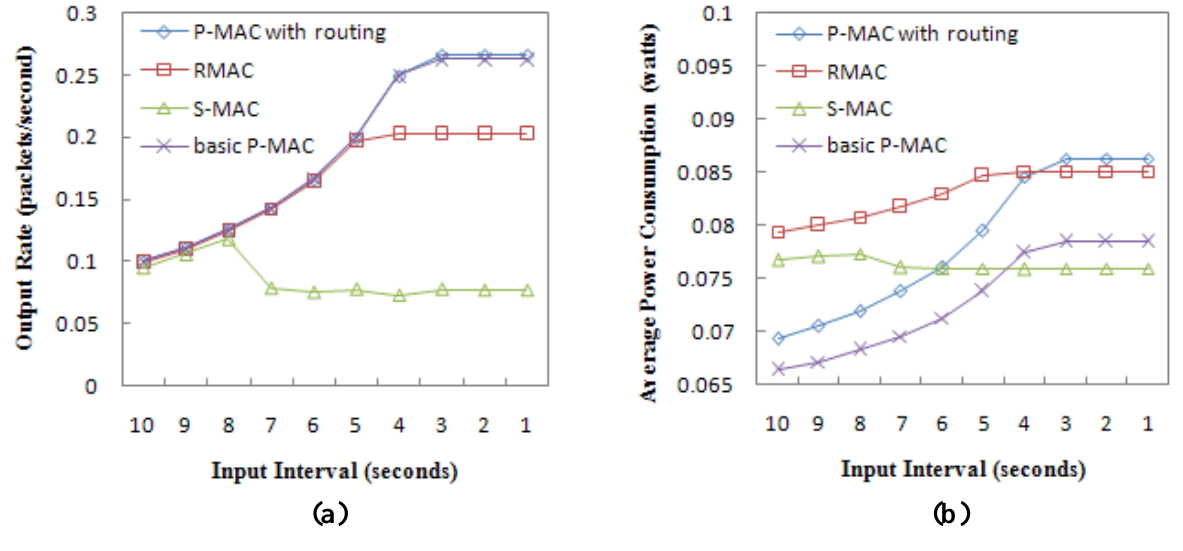
Figure 10. (a) Throughput in the chain topology. (b) Average power consumption per sensor node in the chain